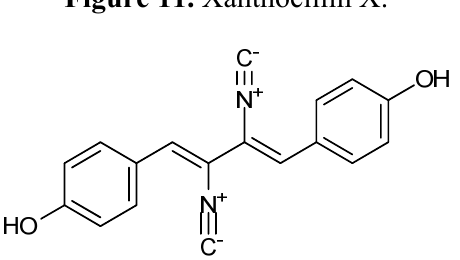
Figure 11. Xanthocillin X.